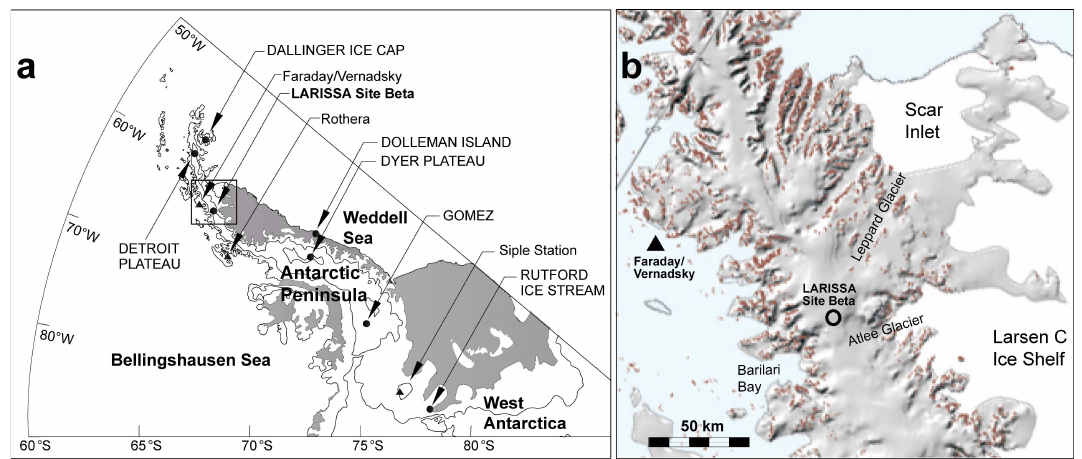
Fig. 1. Maps of the study area. (a) Overview of sites used for latitudinal assessment of climate trends; inset box is area of (b) . Panel (b) shaded relief map of the LARISSA Site Beta area (modified from a British Antarctic Survey base map for the region). Triangles are weather station locations; circles are ice core